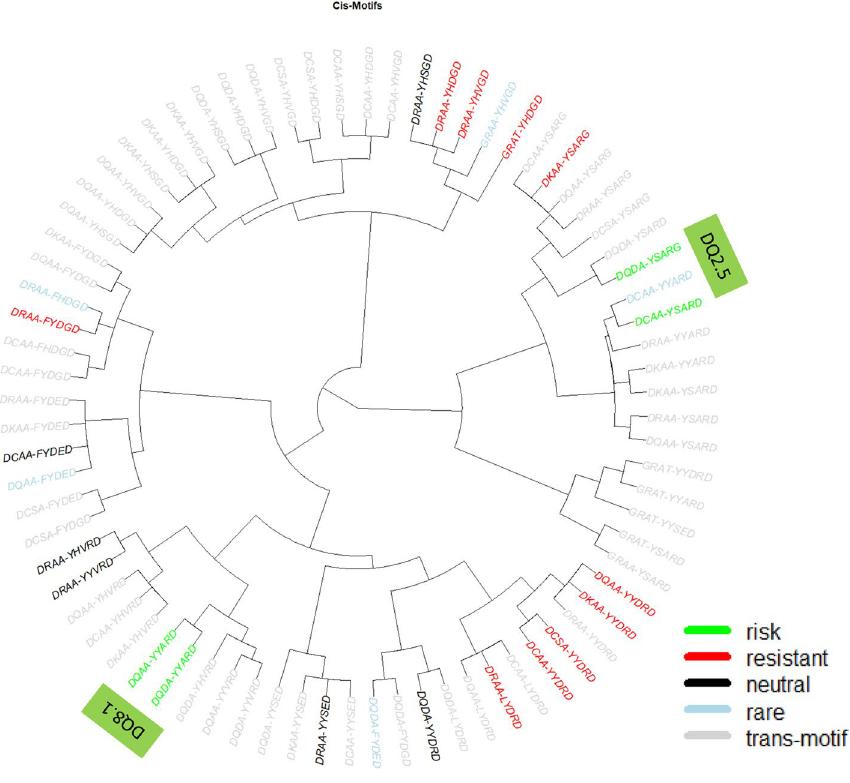
Figure 1. Phylogenic representation of all cis DQ motifs that are risk to (p < 0.05 and OR > 1, colored green), resistant to (p < 0.05, OR < 1, colored red), neutral (p > 0.05, black), and rare (with fewer than 5 observed motif copies, colored blue), together with all trans-DQ motifs (colored